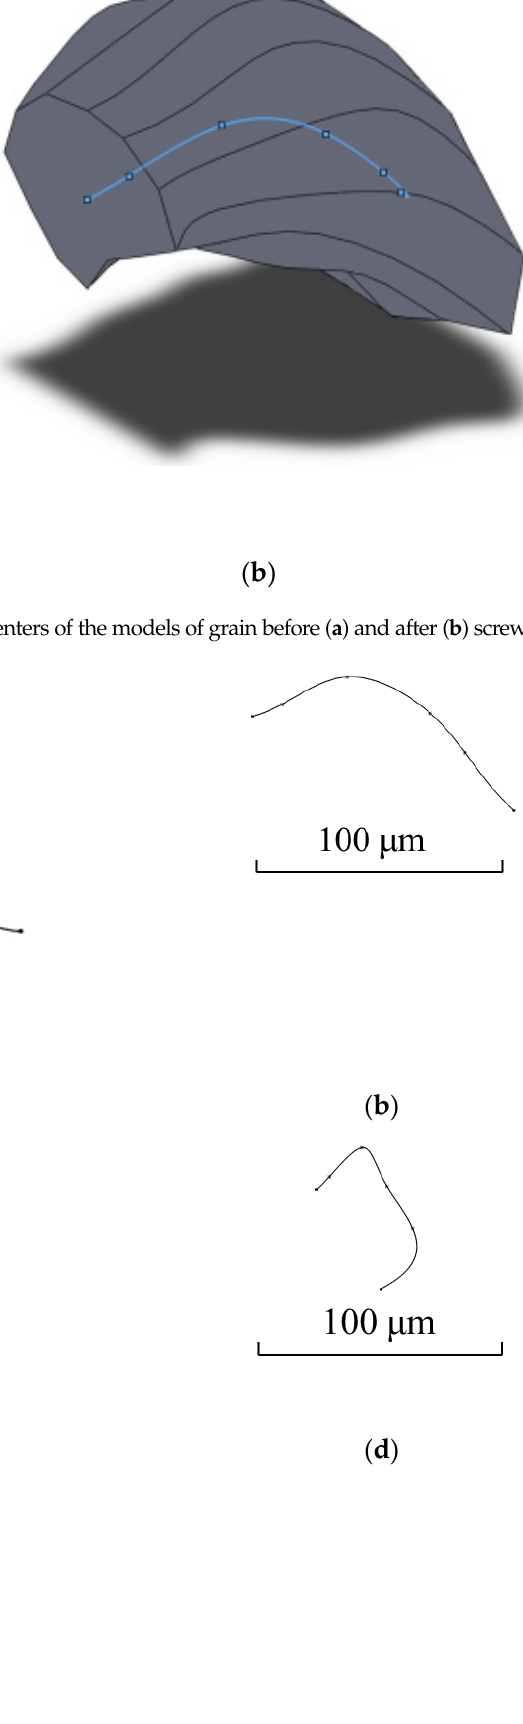
( f ) Figure 10. Spline passing through the cross-sections’ centers of the 3D model of grain before screw rolling ( a , c , e ) and spline passing through the cross-sections’ centers of the 3D model of grain after screw rolling ( b , d , f ): side views ( a , b ); front views ( c , d ); top views ( e , f ). Figures 9 and 10 allow the visual estimation of several changes: the maximum dis- tance between cross-sections centers by height, width, and length of the 3D model of grain before screw rolling differ from the same parameters for the 3D model of grain after screw rolling. The maximum distance between the cross-section centers of the 3D grain models